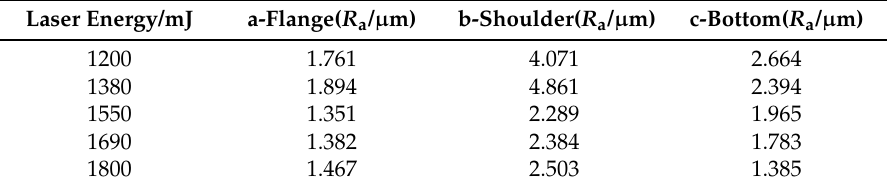
Table 3. Surface roughness values of three areas under different laser energy.